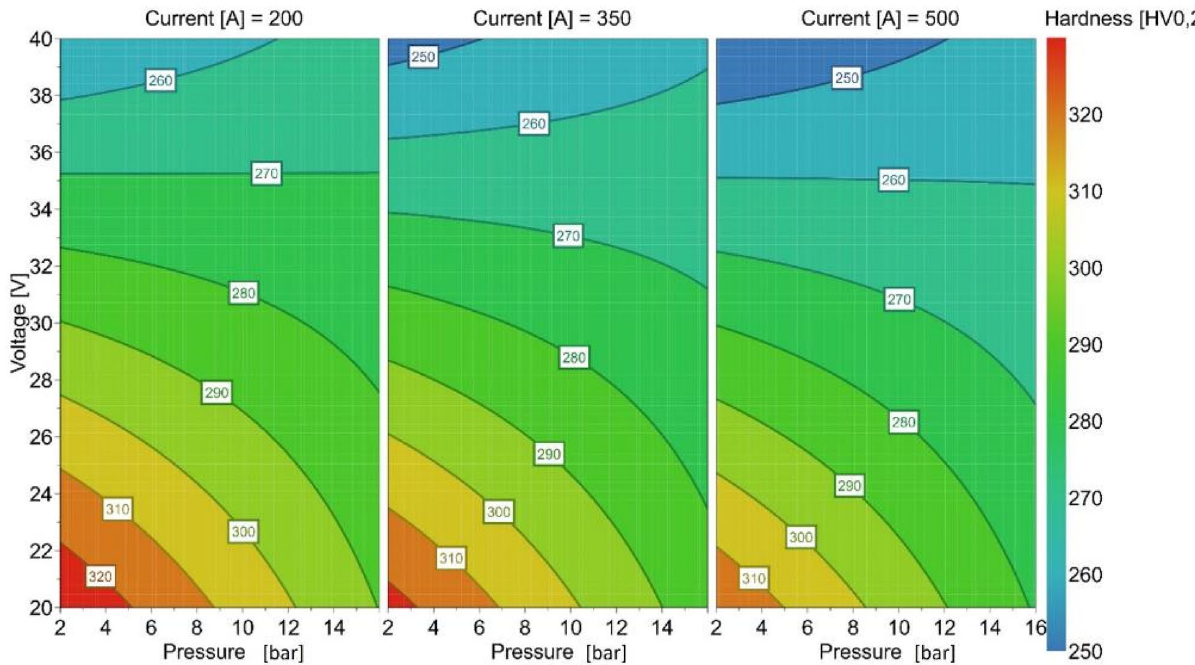
Figure 12. Contour plot hardness in dependence of ambient pressure, welding voltage and welding